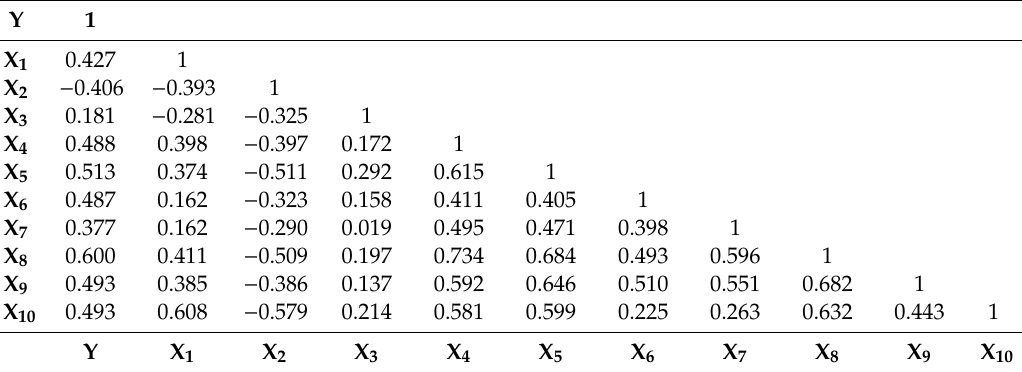
Table 2. Linear correlations of dependent variables and independent